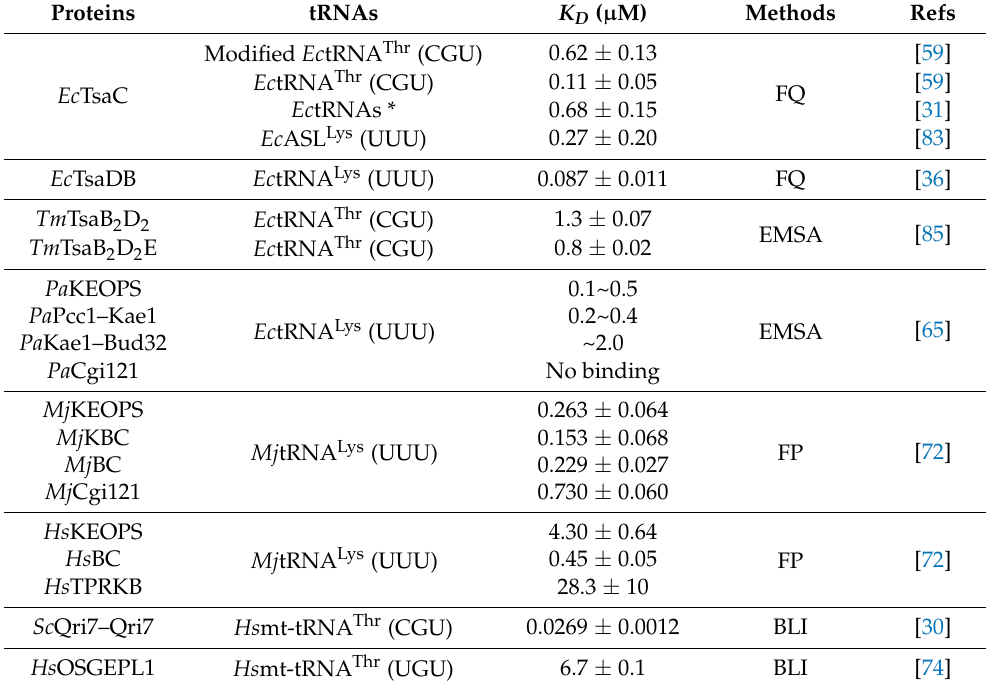
Table 4. Summary of K D values of the binding between tRNA t 6 A-modifying enzymes and tR- NAs. Abbreviations: Ec , E. coli ; Tm , T. maritima ; Pa , P. abyssi ; Mj , M. jannaschii ; Sc , S. cerevisiae ; Hs , H. sapiens ; mt, mitochondrial; FQ, fluorescence quenching; EMSA, electrophoretic mobility shift assay; FP, fluorescence polarization; BLI, biolayer interferometry; TsaDB, TsaD–TsaB; TsaB 2 D 2 ,